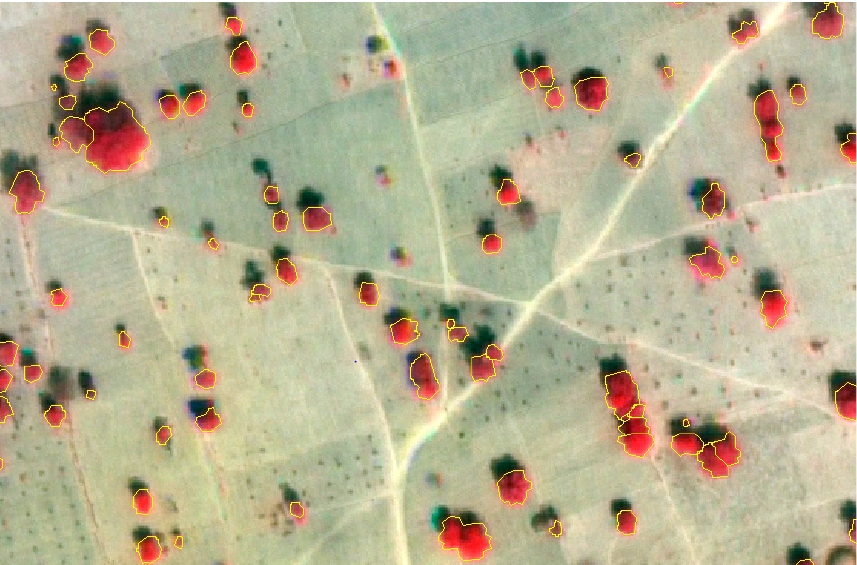
Figure 3. A subset of the WorldView ‐ 2 imagery (dry season) acquired over KCSZ is shown as a false ‐ colour RGB composite consisting of NIR 1, red, and green bands, and tree crowns extracted using GEOBIA. Table 3. Vegetation indices-based predictor used for tree species